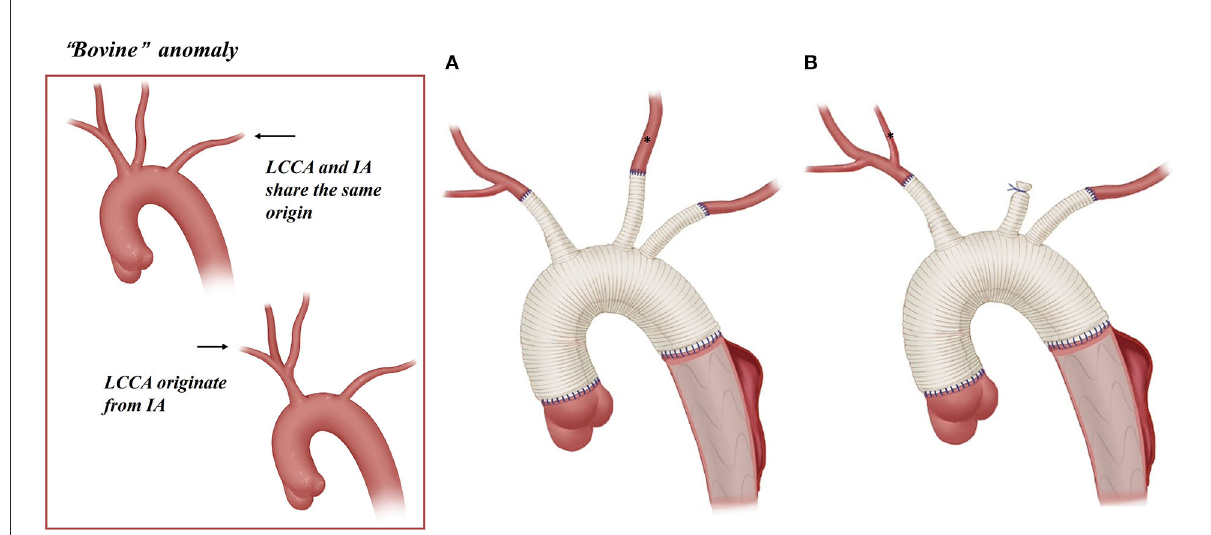
FIGURE3 Arch technique for “bovine” anomaly in patients with type A aortic dissection. *LCCA; (A) reconstruction with three graft branches for “bovine” anomaly. (B) Reconstruction with two graft branches for “bovine” anomaly.